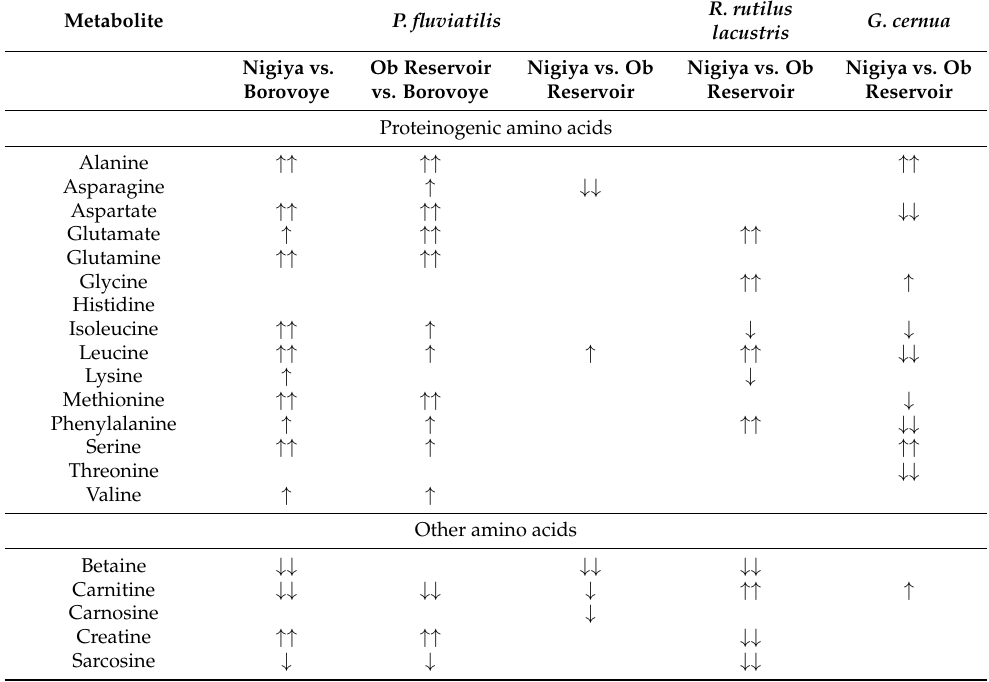
Table 2. Comparison of metabolite concentrations in lenses of P. fluviatilis, R. rutilus lacustris , and G. cernua between basins. Statistically significant difference: no arrow—no difference, sin- gle arrows— p -value < 0.05, and double arrows— p -value < 0.01. Increase or decrease in the metabolite concentration is indicated by the direction of arrows (e.g., alanine “ ↑↑ ” in “Nigiya vs. Borovoye” means that alanine in Nigiya was higher than in Borovoye with p -value < 0.01).